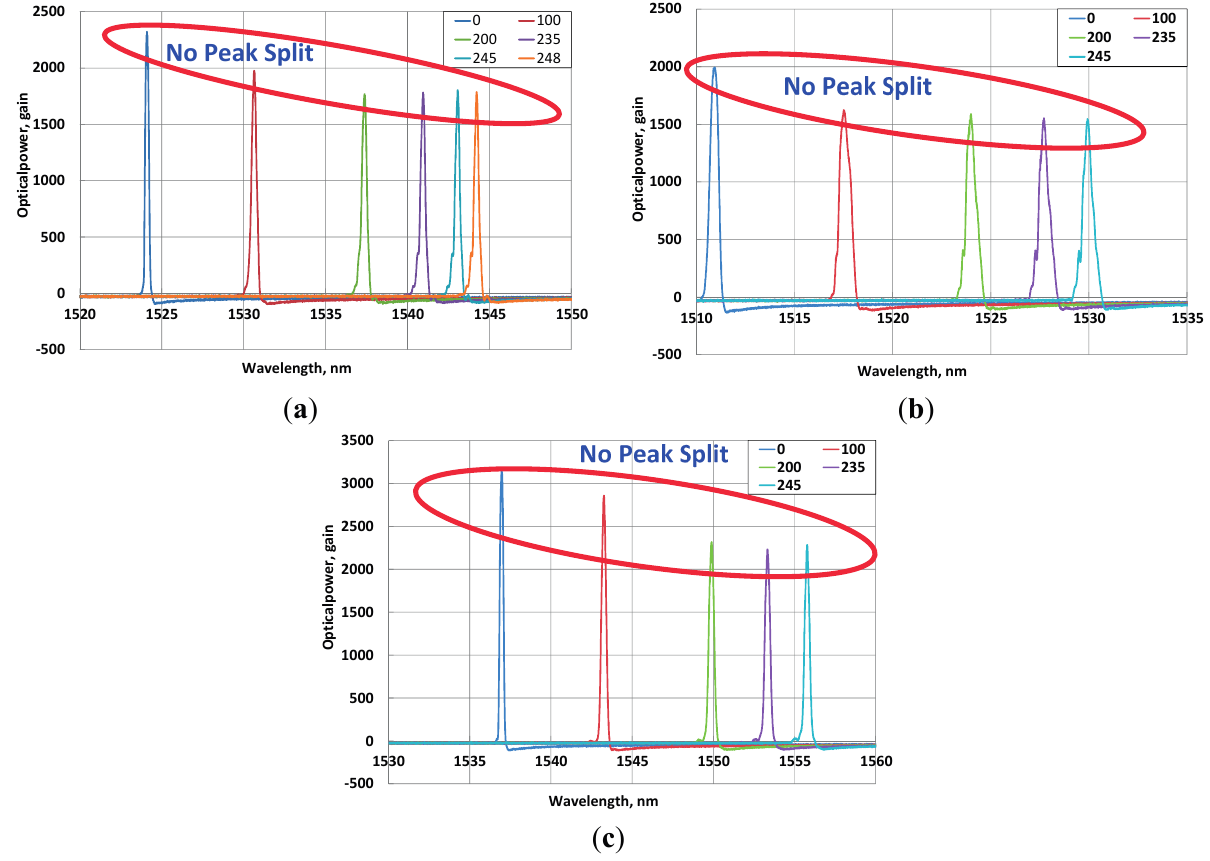
Figure 10. Load-spectrum change in ( a ) 20-mm; ( b ) 30-mm and ( c ) 50-mm